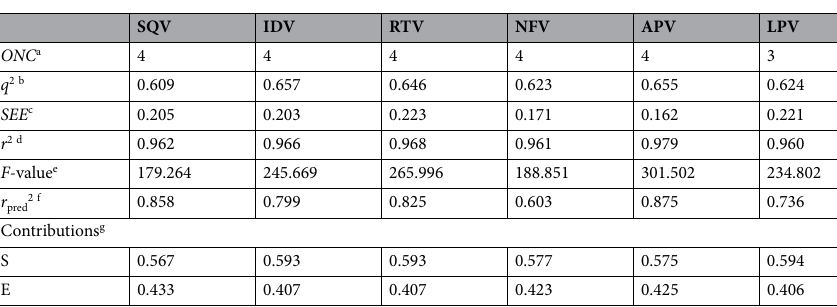
values in the training and test set are smaller than 1.0 log unit, which indicated the quite well predictive ability of the constructed MB-QSAR models. Here we derived the 3D coefficient contour maps of CoMFA models which can show the structural impacts on the binding of drugs, thus can provide a view of the drug resistance mechanisms (Fig. 4 and Fig. S2). The contours were mapped on the structure of wild-type HIV PR complexed with inhibitors. The CoMFA steric interactions are represented by green and yellow contours, while CoMFA electrostatic interactions are shown with red and blue contours. The bulky substituents in HIV PR are favorable in the green regions of steric contours for enhancing the inhibitory activity, while those in yellow regions may lead to a decrease in inhibitory activity. Meanwhile, in the map of the electrostatic field, the blue contours indicate that electropositive charges in HIV PR are favored for inhibitory activity, while the red contour designates an increase in inhibitory activity of the electronegative charges. As shown in Fig. 4 and Fig. S2, the yellow contours surrounding the residueGly48 and Gly48 ′ in the complex of HIV PR with SQV, IDV, NFV and LPV indicated that the steric interactions were not favorable for the bind- ing of PIs, which are consistent with the fact that introduction bulky residue in this site can caused resistance to PIs 34 . The Gly48 of HIV-1 PR mainly interacts with these inhibitors through the interaction between its backbone atoms (Fig. S3). The introduction of bulky residues such as valine and methionine in this site can disrupt the